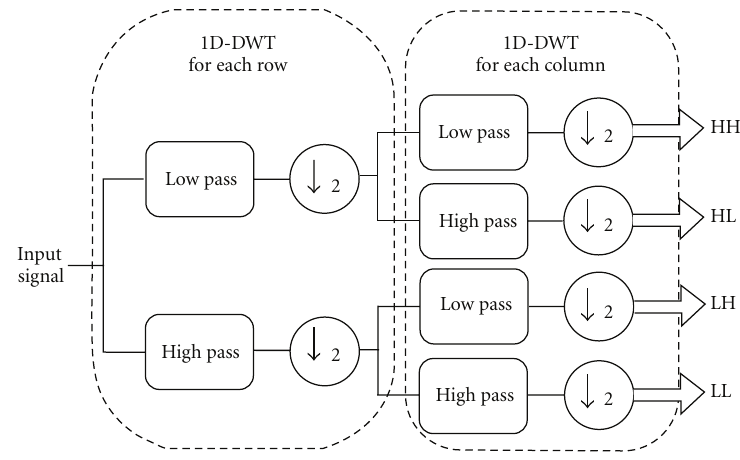
Figure 2: 2D DWT filter